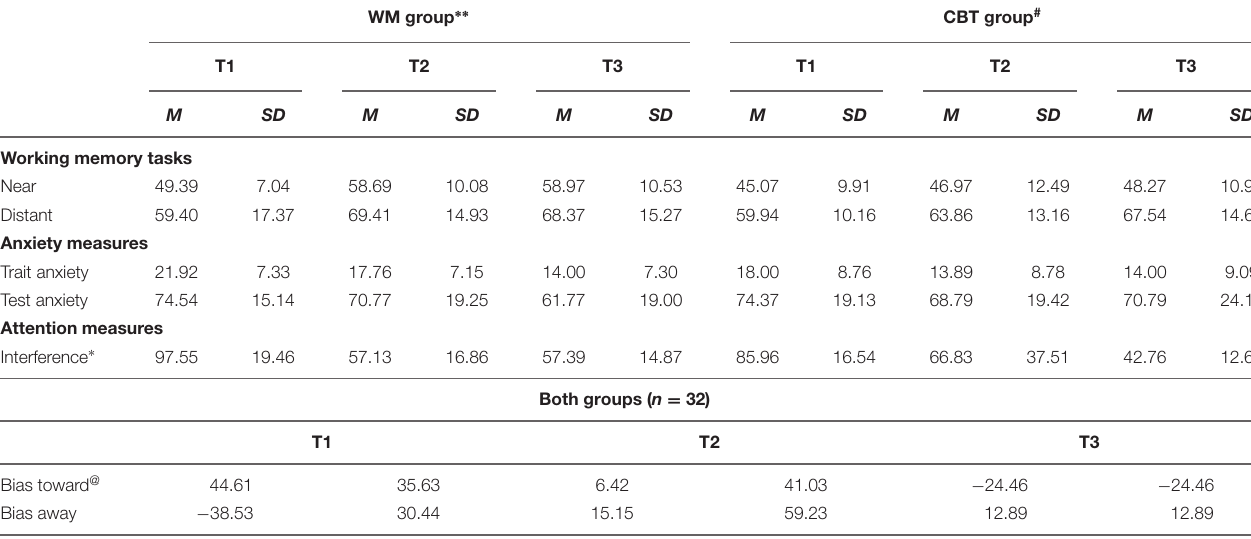
TABLE 1 | Mean (SD) and range of working memory (WM) (% near and distant correct), anxiety symptoms, stroop interference score (ms), attentional bias score (ms) at measures at time 1 (T1- pre-intervention), time 2 (T2 – post-intervention) and time 3 (T3 – follow-up) in the WM and CBT